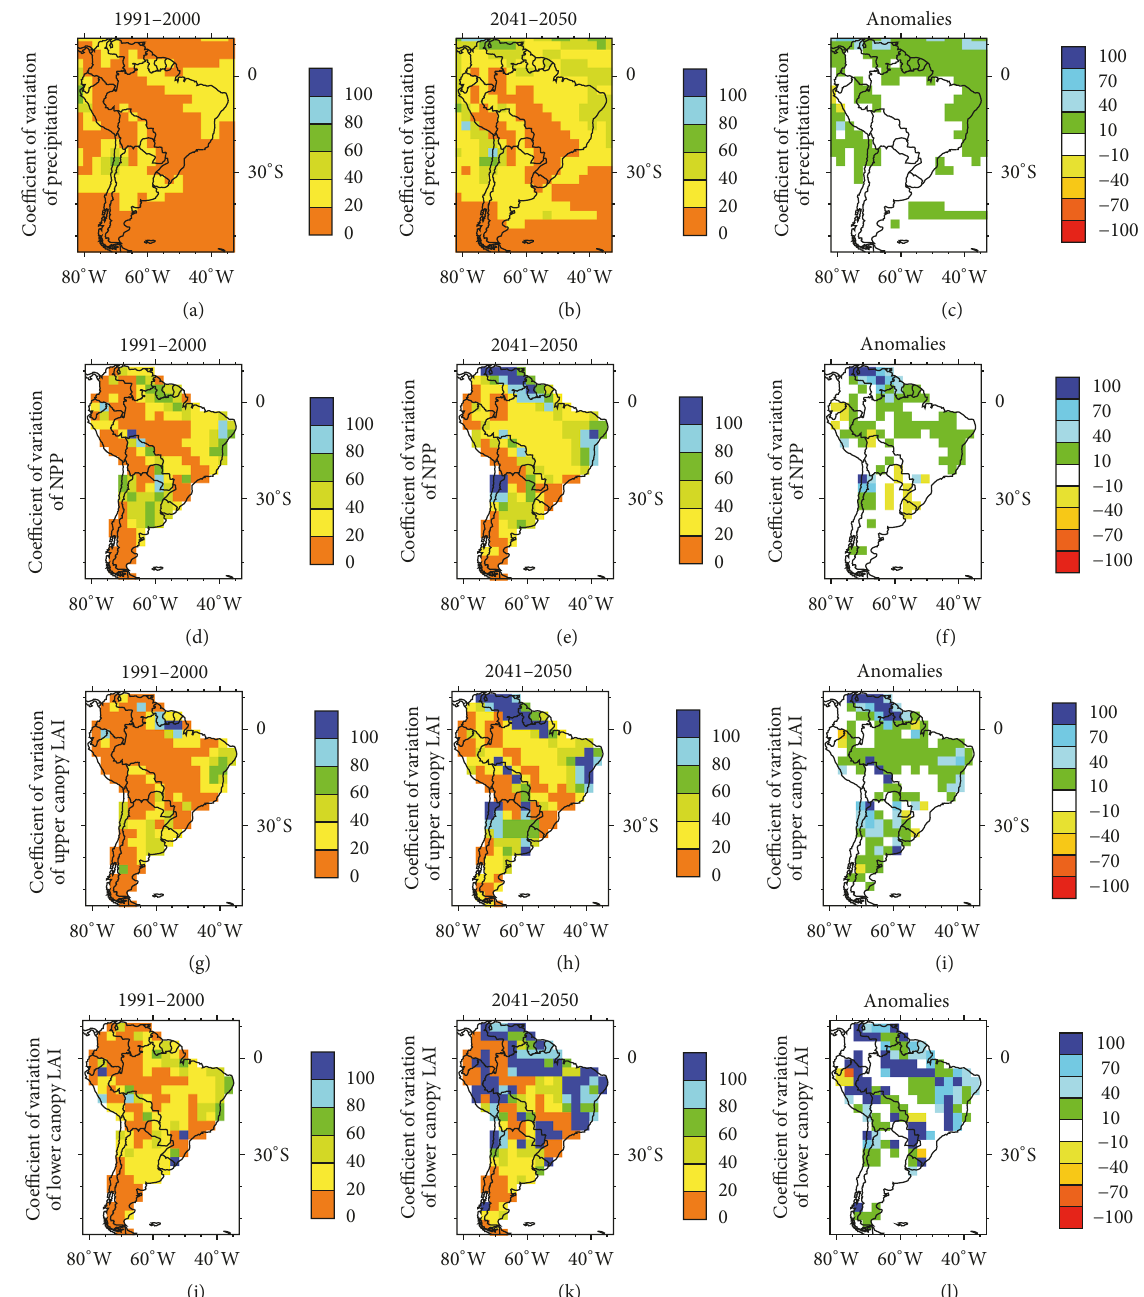
Figure3:Coefficientsofvariationofprecipitation(a-b),theNPP(d-e),uppercanopyLAI(g-h),andlowercanopyLAI(j-k)inSouthAmerica over present-day conditions (1991–2000) (a, d, g, j) and future scenario (2041–2050) (b, e, h, k) and anomalies (2041–2050; 1991–2000) (c, f, i,